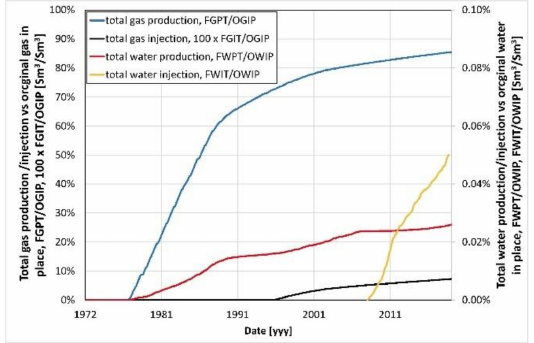
Figure 15. Total gas production / injection relative to original gas in place. Total water production / injection relative to original water in